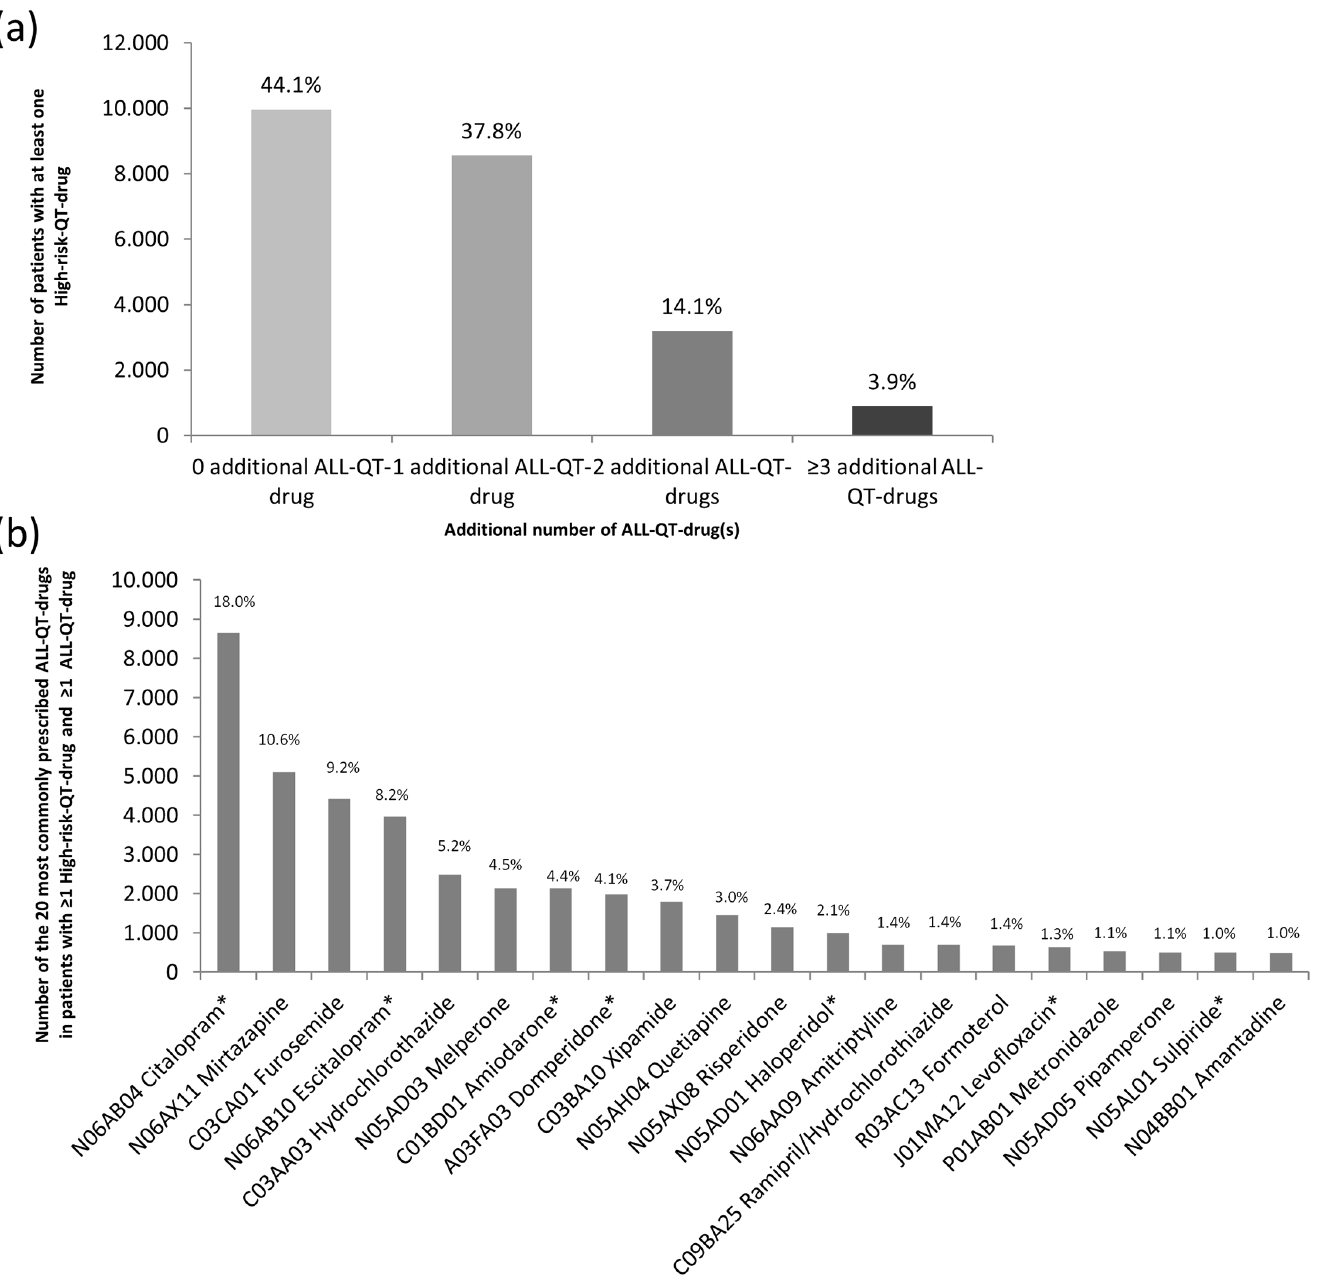
Fig 2. Patients taking at least one High-risk-QT-drug with additional number of ALL-QT-drug(s) and TOP 20 of their QT-drugs. (a) Number of patients (%) with at least one High-risk-QT-drug (N = 22,599) receiving or not additionally ALL-QT-drug(s) simultaneously. In 44.1% (N = 9,966) of the patients with at least one drug of the High-QT-risk no additional ALL-QT-drug was prescribed while 55.9% (N = 12,633) of the patients with at least one drug of the High-QT-risk-group received additionally at least one ALL-QT-drug. (b) TOP 20 of the most commonly prescribed QT-drugs in patients with at least one High-risk-QT-drug and at least one additional ALL-QT-drug. The number of these QT-drugs represents 85.1% of all prescribed QT-drugs (N = 48,161) in this group of 12,633 patients. *